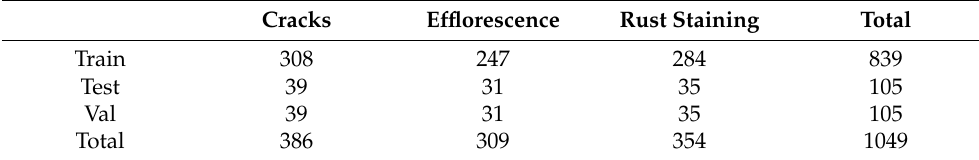
Figure 5. Main types of BDD datasets and presentations. ( a ) Normal background image with no damage to the target ( b ) cracks ( c ) efflorescence ( d ) rust staining. Table 1. The detailed classification table of the BDD data set (including Cracks, Efflorescence, Rust Staining three categories divided into Train, Test, Val three independent datasets used for the model establishment and evaluation in the ratio of